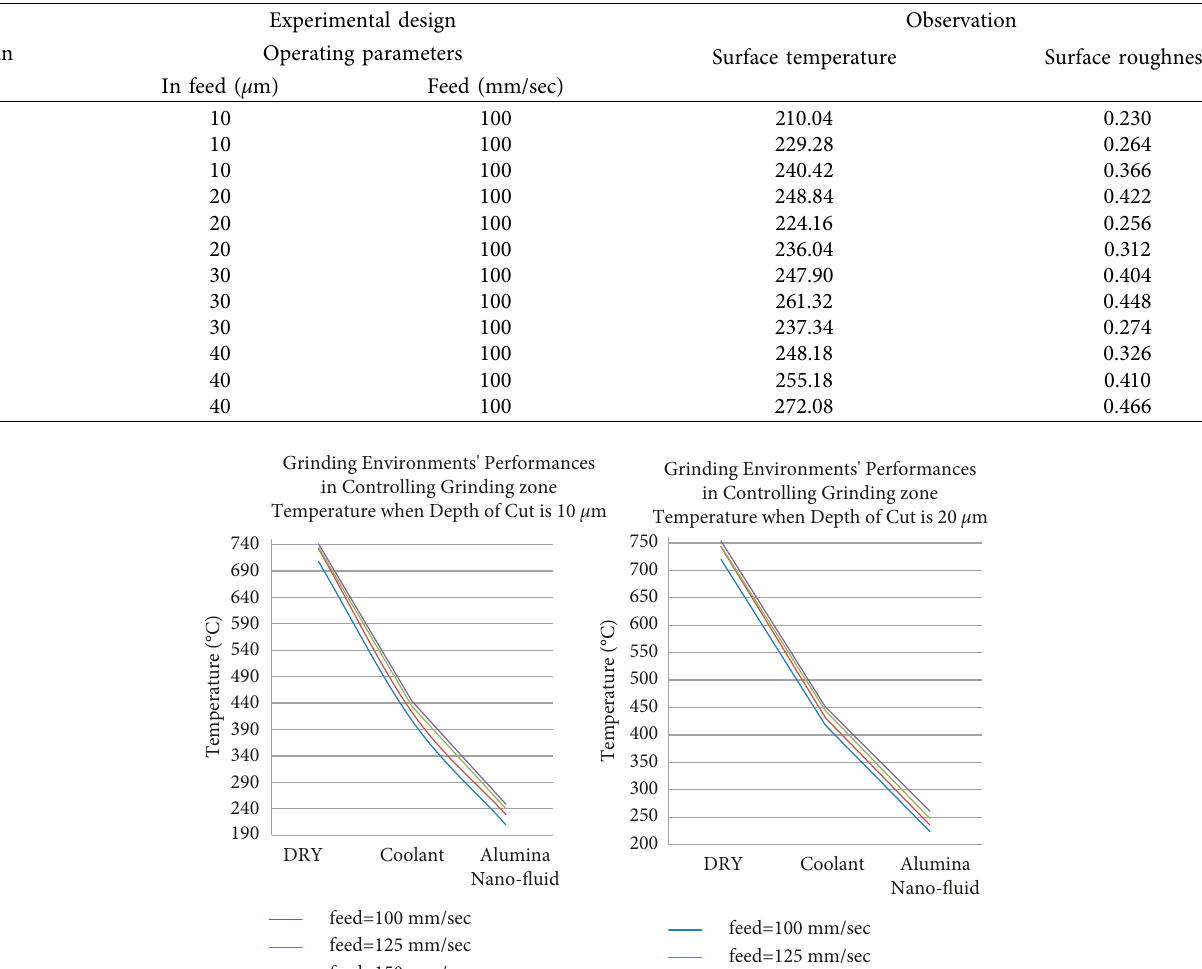
Table 7: Taguchi full factorial design: machining with nanofluid as coolant.